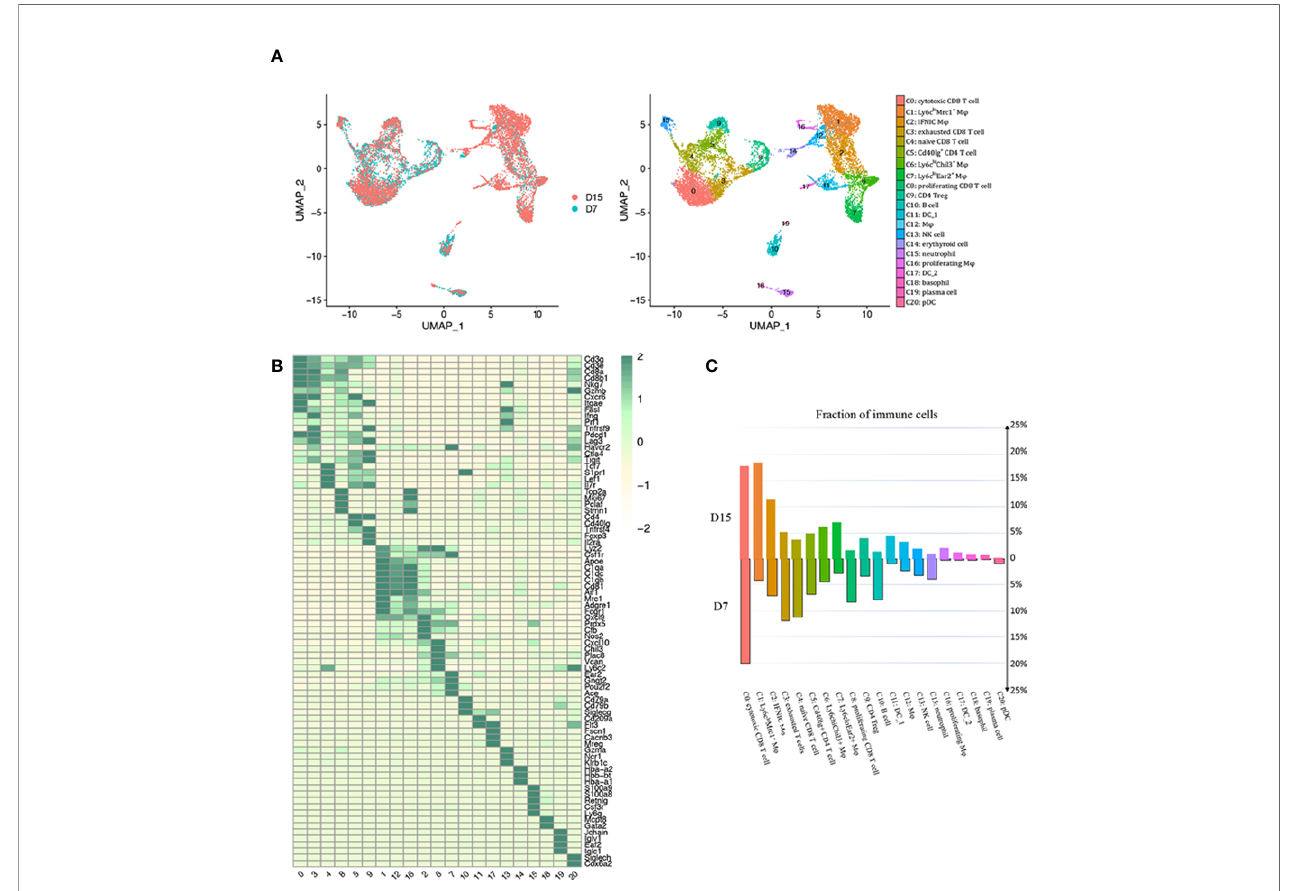
FIGURE 2 | scRNA-seq of mice kidney allograft revealed the presence of 20 CD45 + immune cell clusters. (A) UMAP plot of cell clusters identi fi ed based on the expression of highly variable genes. Each dot depicts a single cell, colored according to cluster designation. Cell identities are annotated on the right. (B) Heat map showing the marker genes in each cell cluster identi fi ed through unsupervised clustering of kidney graft immune cells. Average expression scale is shown on the right. Cell identities are annotated as in (A) . (C) Bar plot showing the proportions of 20 immune cell populations in kidney allografts collected 7 days and 15 days following transplantation, respectively, colored according to cluster designation in (A) . UMAP, Uniform Manifold Approximation and Projection; M j , macrophage; DC, dendritic cell; NK, natural killer; pDC, Plasmacytoid dendritic